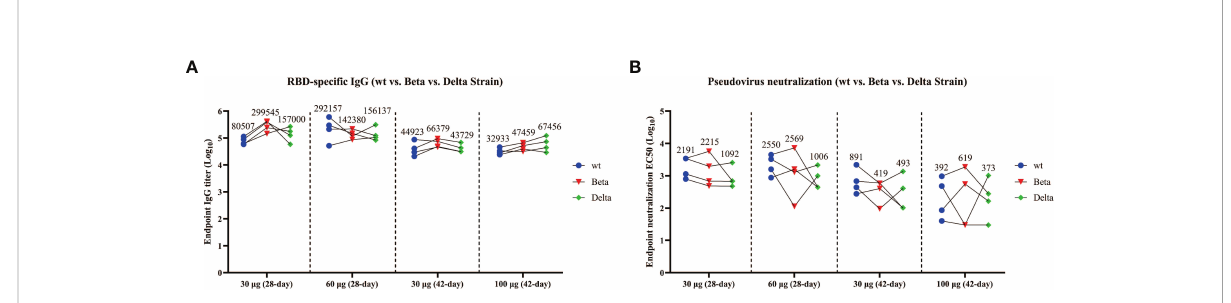
FIGURE 3 Cross-reactivity of the antisera from mice immunized with wtRBD against Beta and Delta SARS-CoV-2 variants. The endpoint serum samples from mice immunized with wtRBD according to immunization program 1 and 2, which had the immunization intervals of 28 and 42 days, respectively, were used for the IgG binding antibody and NAb assay. (A) Titers for IgG binding antibody against the Beta and Delta variant. (B) Titers for NAbs against the Beta and Delta variant. Each symbol indicates data from one mouse (n = 4 mice/group); geometric means of each group are